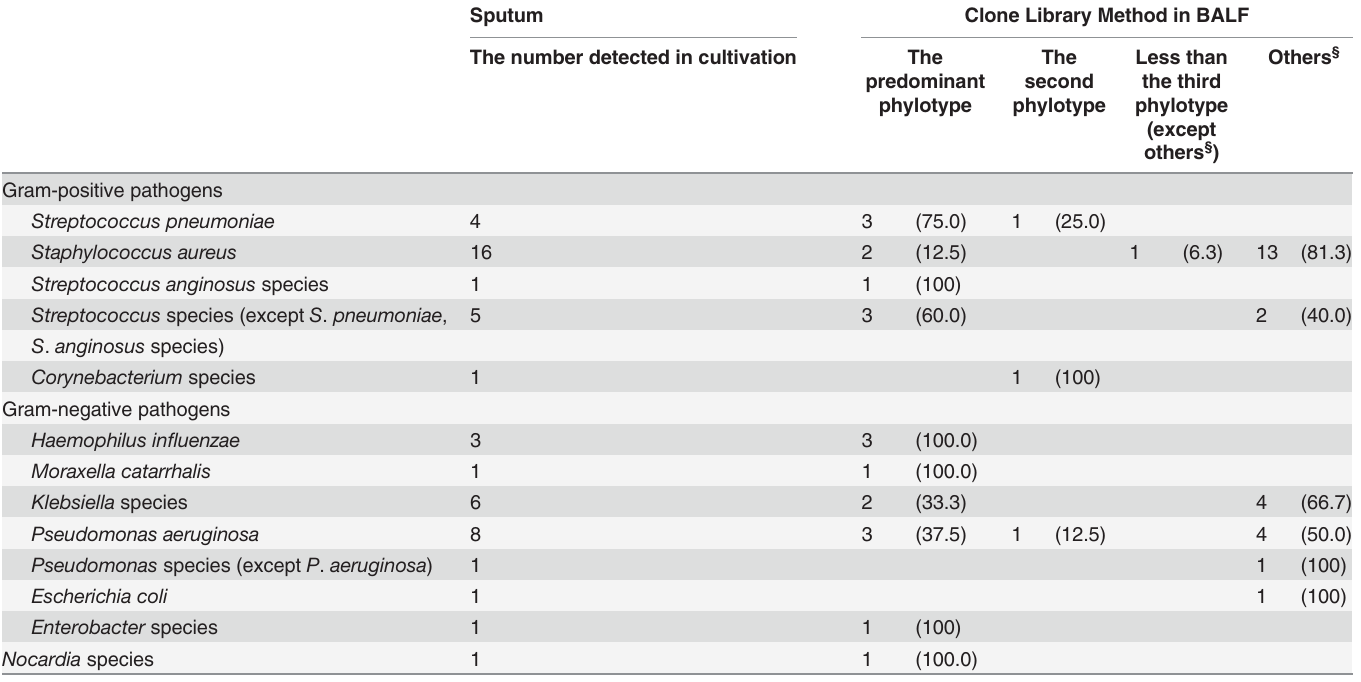
Table 3. The difference of bacteria according to the molecular method in sputum